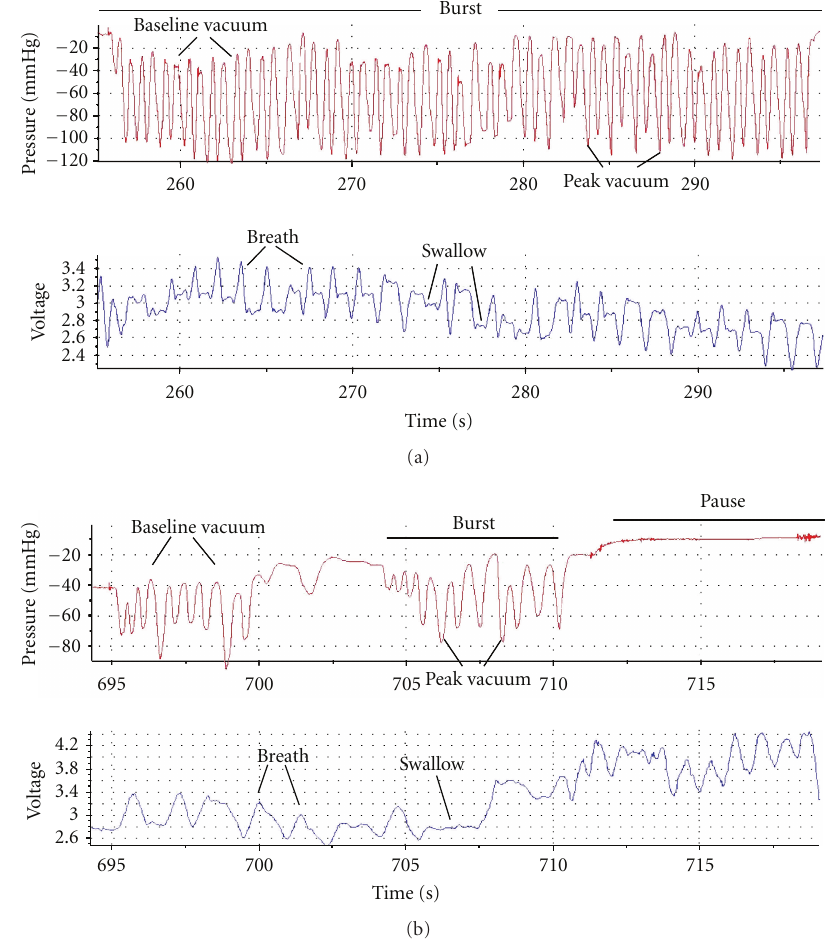
Figure 2: Trace of a suck-swallow-breathe burst of an infant during (a) nutritive sucking (NS) and (b) non-nutritive sucking (NNS) during the monitored breastfeed. During the NS burst, there are more sucks, swallows, and breaths, and the burst is longer than NNS.